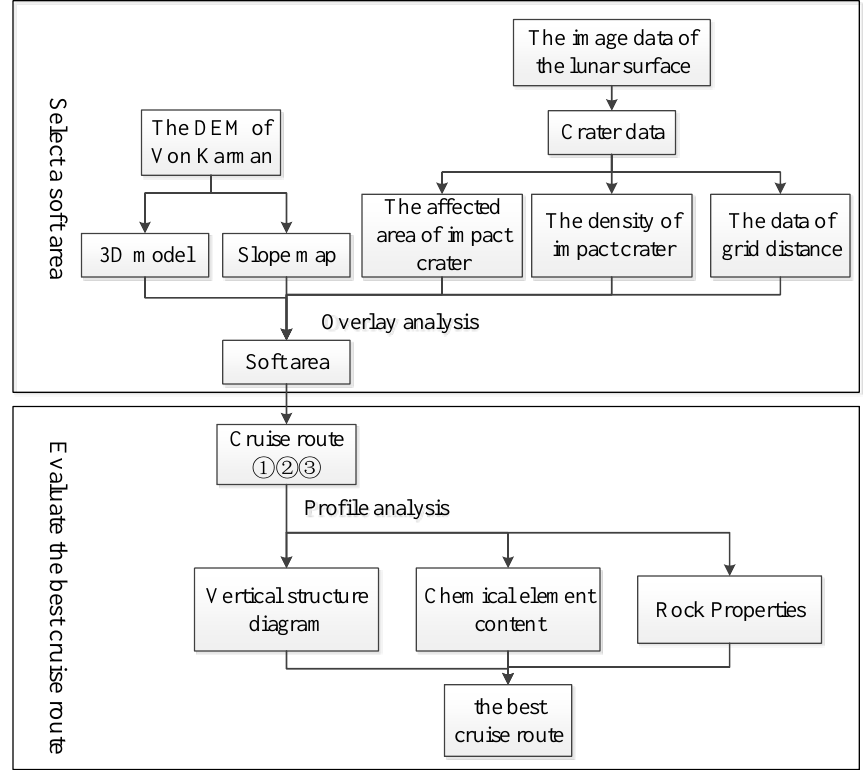
Figure3. Flow chart of the assessment of the